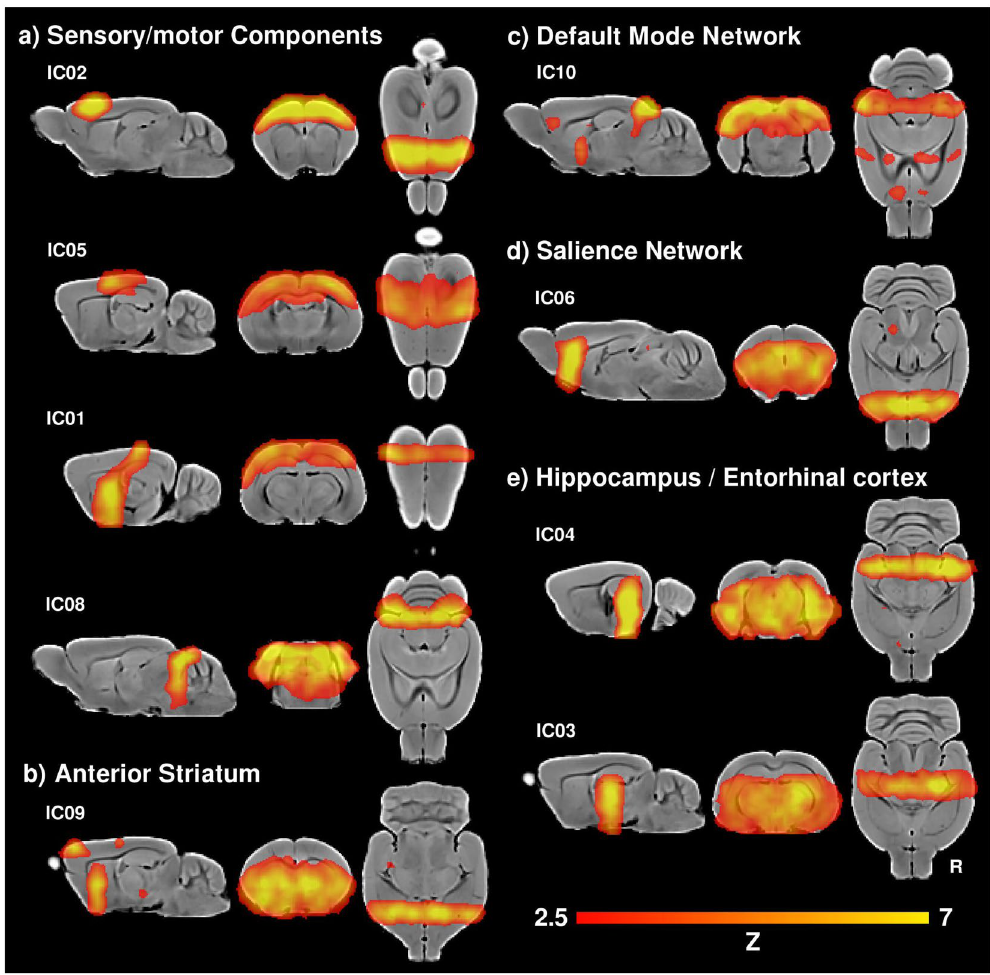
Figure 2. Ten components gICA. ( a ) Sensory/motor components, including motor cortex (IC02), parietal cortex (IC01, IC05), colliculi (IC08). ( b ) Striatum and frontal association cortex. ( c ) Default mode network. ( d ) Salience network. ( e ) Hippocampus and entorhinal cortex (IC03,